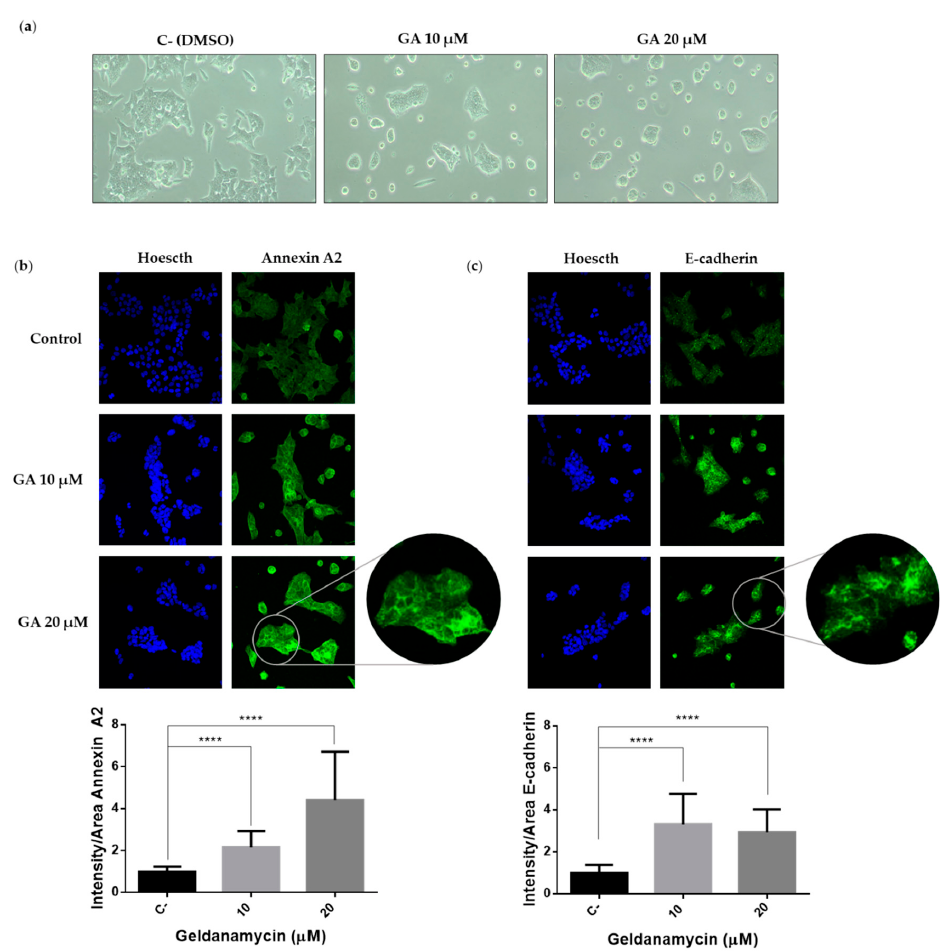
Figure 6. Geldanamycin induces an epithelial-like phenotype accompanied by an increase expression of E-cadherin and Annexin A2: HCT116 cell line was treated at the indicated concentrations of geldanamycin (GA) for 24 h. ( a ) Images of HCT116 were taken by optical microscopy. ( b ) Representative immunofluorescence images of Annexin A2 are shown (upper panel) and fluorescence intensity quantification is represented (lower panel). ( c ) Representative immunofluorescence images of E-cadherin are shown (upper panel) and fluorescence intensity quantification is represented (lower panel). Images were taken with confocal microscope by employing 40× magnification objective. A zoom image of 80X magnification was included. Annexin A2 and E-cadherin were stained in green, and cell nuclei were counterstained with Hoechst. Quantification of intensity/area was represented as Mean ± SEM (**** p < 0.0001).